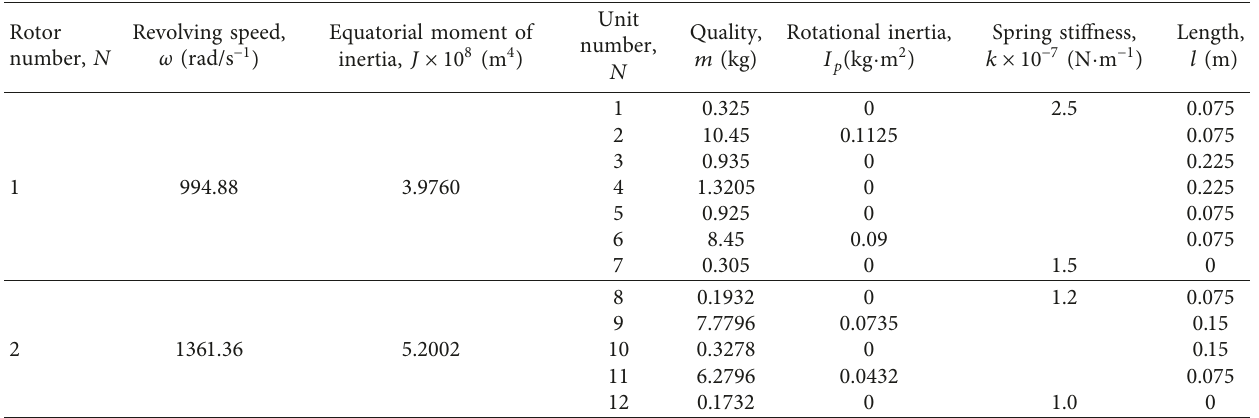
Table 1: Original data